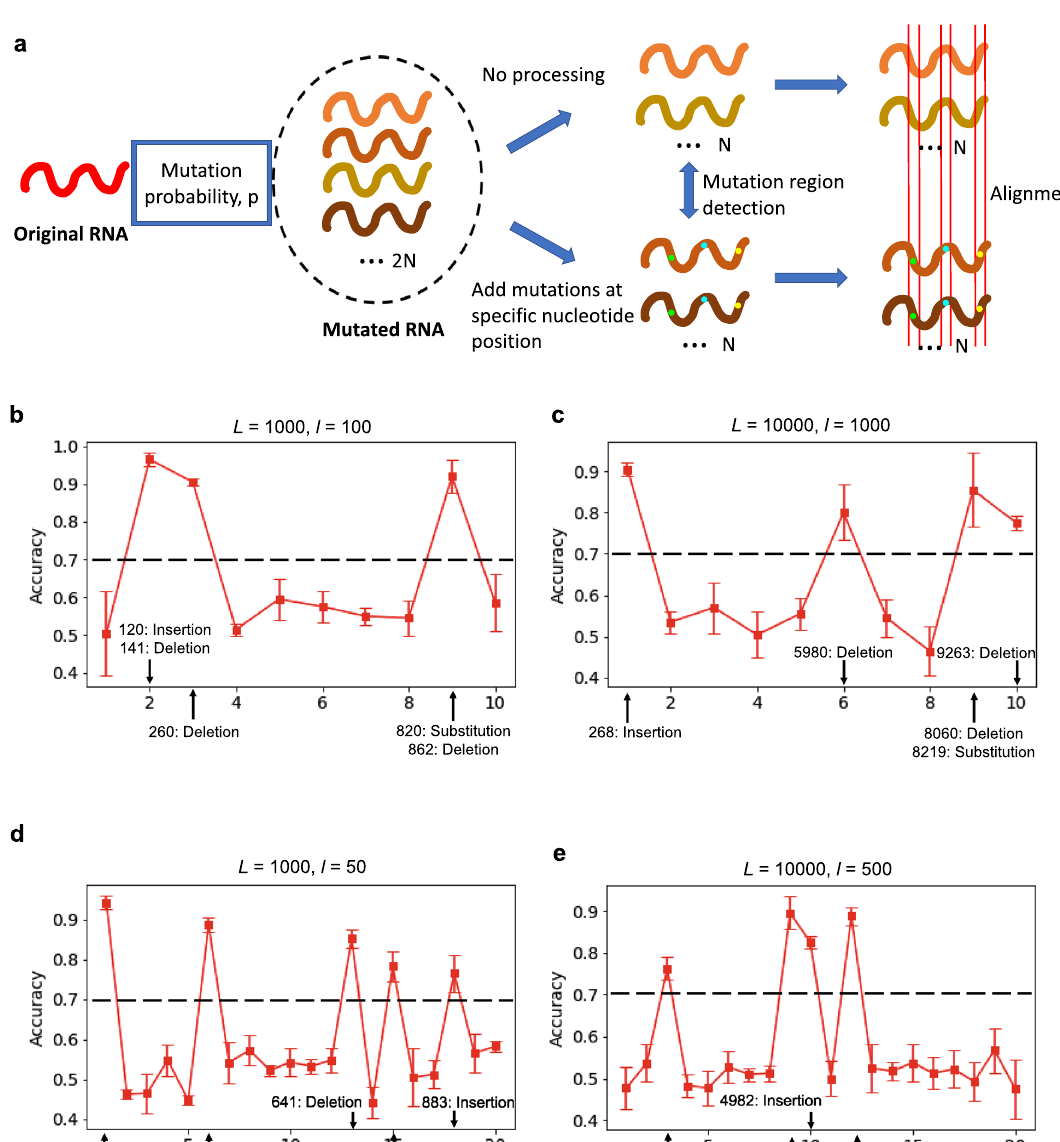
ciently process large sets of genomic sequences. In this part, we show how the mutation region detection method we proposed above can be used to aid alignment techniques and show faster performance compared to the state of the art alignment techniques.